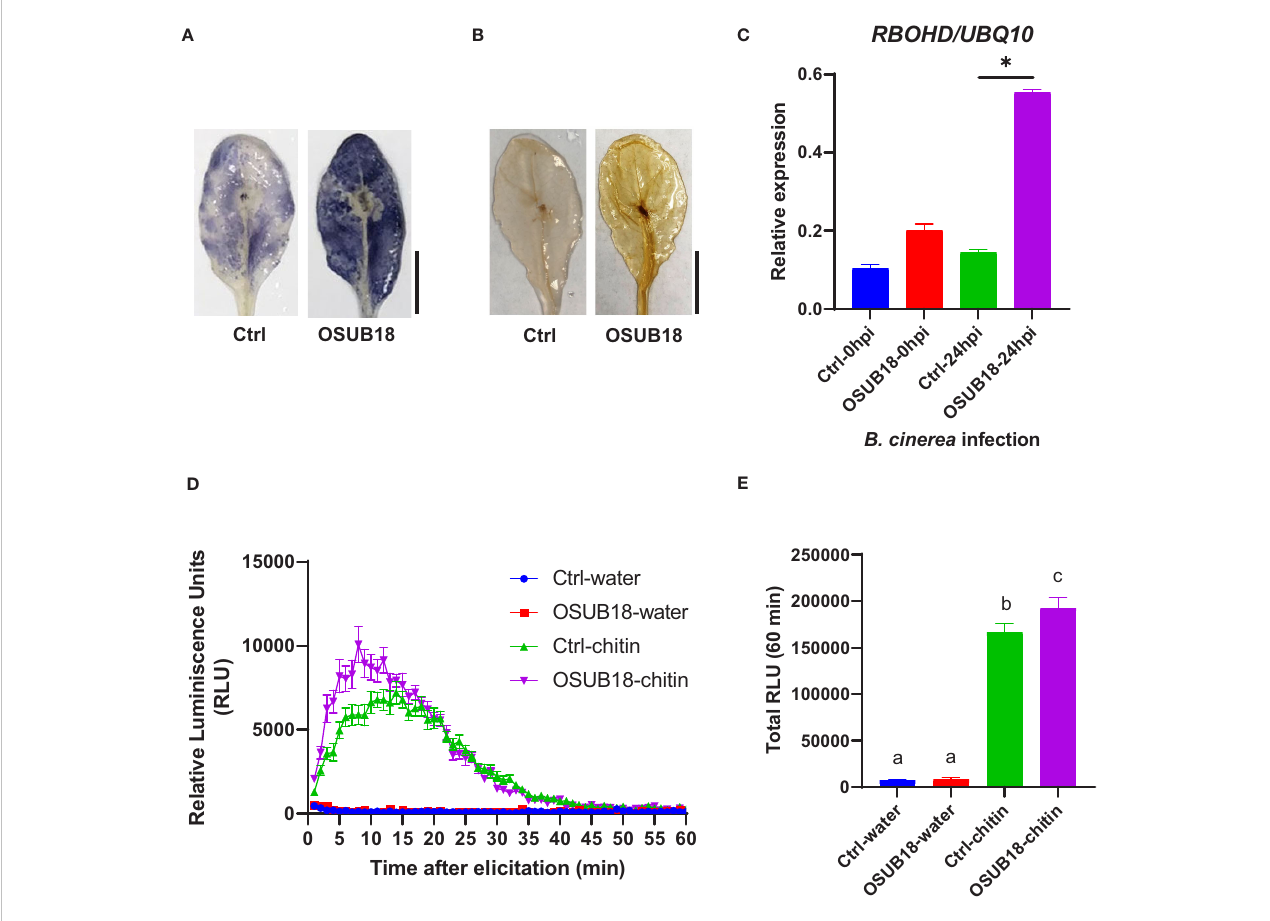
FIGURE 7 OSUB18 root drench treatment triggered strong ISR in A thaliana against the fungal pathogen B cinerea via signi fi cantly stronger ROS production and higher RBOHD gene expression. (A) Col-0 plants drenched with OSUB18 produced more intense superoxide anion upon the B cinerea infection (24hpi), as illustrated by the nitroblue tetrazolium (NBT) staining assay. Scale bar = 10 mm. (B) Col-0 plants drenched with OSUB18 produced more intense hydrogen peroxide upon the B cinerea infection (24hpi), as illustrated by the 3,3-diaminobenzidine (DAB) staining assay. Scale bar = 10 mm. (C) Relative gene expression of the ROS-responsive gene RBOHD . Water or OSUB18-drenched plants were infected with B cinerea spores. 0 or 24 hours later, the inoculated leaves were collected for the qRT-PCR assay. The UBQ10 gene was used as an internal reference in the qRT-PCR assay. (D) Col-0 plants pre- drenched with OSUB18 showed a more vigorous ROS burst elicited by the fungal PAMP chitin. (E) Quanti fi cation of the ROS burst in (D ). Data present mean ± SE of three biological replicates. Data with different letters or * indicate a p- value < 0.05 on Student ’ s t-test or